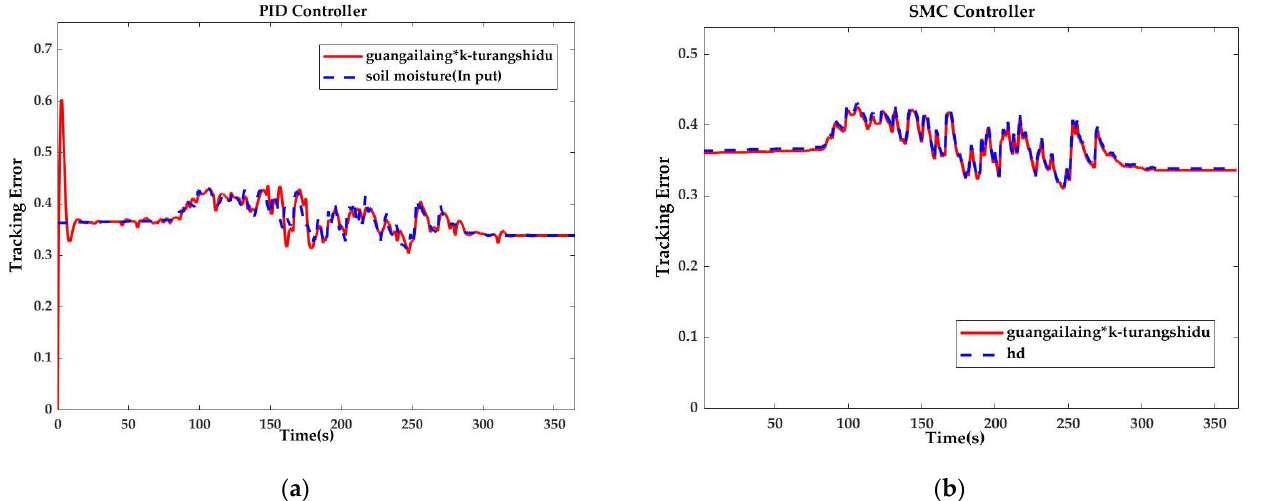
Figure 16. Comparison of simulation results for different controllers: ( a ) simulation results of the PID controller; and ( b ) simulation results of the SMC controller.